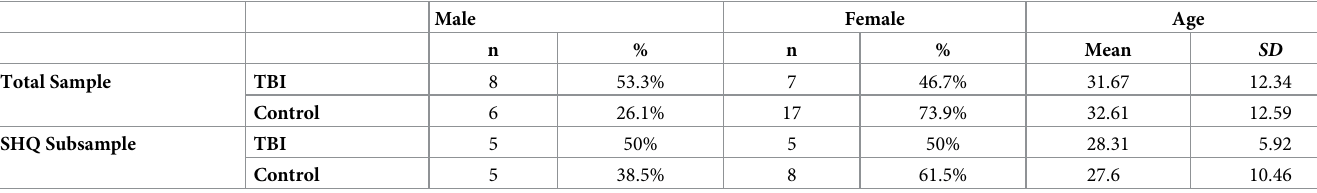
Table 1. Demographic characteristics of TBI and control